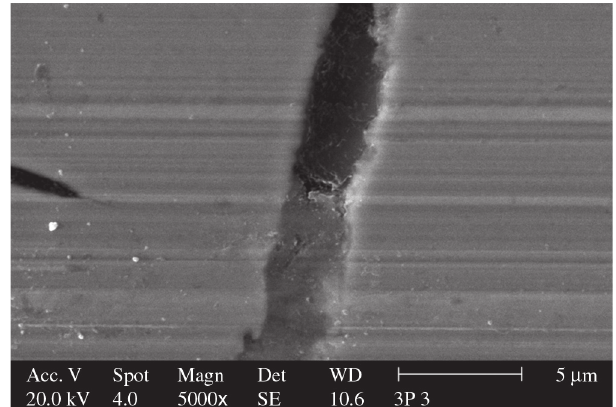
Figure 5. Plastic deformations on the operating surface of brake disc, SEM image, SE mode.